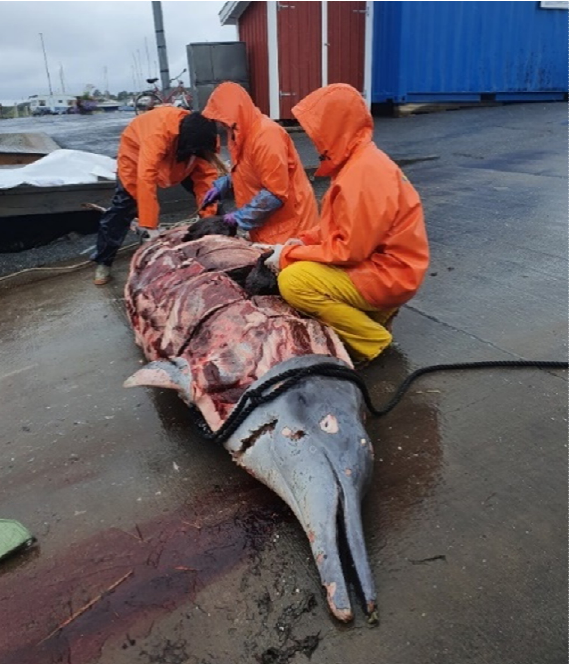
Figure 6. Field necropsy of a Sowerby’s beaked whale ( Mesoplodon bidens ) (Specimen 5). Note the wound on the left side of the jaw. Photo: Anna Bisther. Table 2. Summary of the postmortem findings of the five Sowerby’s beaked whales ( Mesoplodon bidens ) that died in Swedish waters